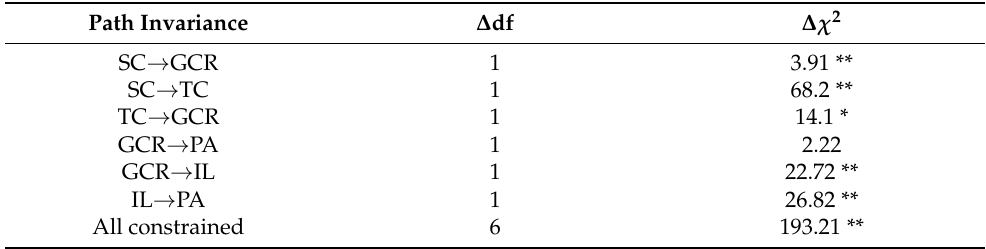
Table 8. Cross-group equality constraints of the path analyses between the high- and low-knowledge